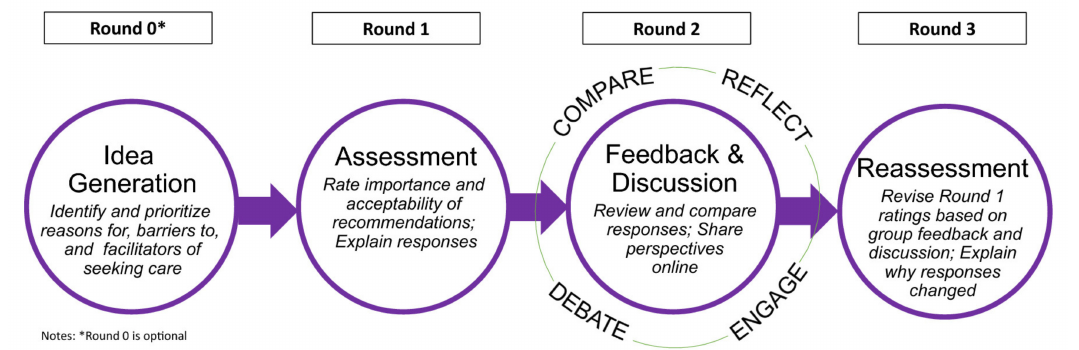
Figure 2. Delphi Method followed for common consensus and clinical recommendations by the expert panel. (Source: Khodyakov, Dmitry et al. “The RAND/PPMD Patient-Centeredness Method: a novel online approach to engaging patients and their representatives in guideline development.”